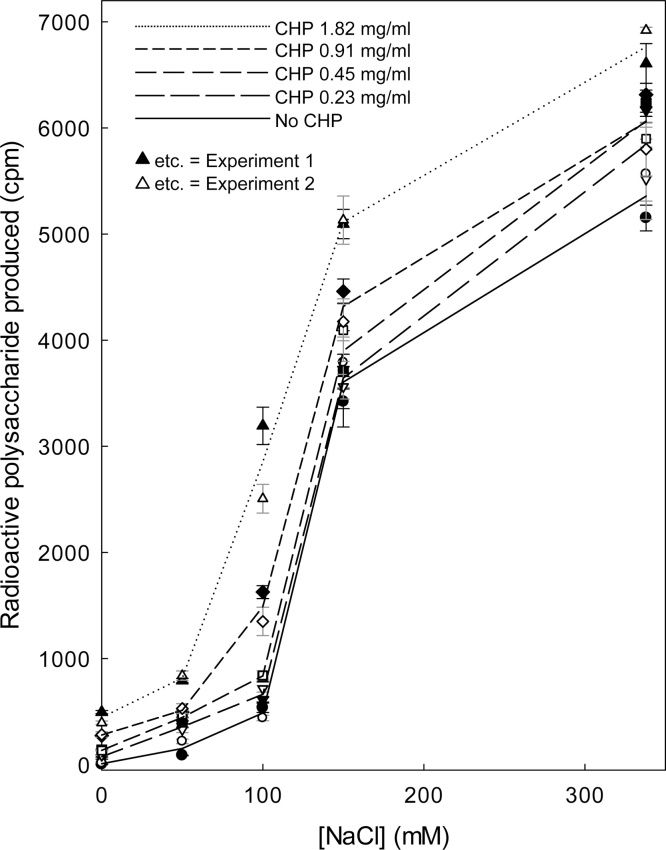
CHP and NaCl synergistically solubilise XET activity from Arabidopsis cell walls. Frozen/washed Arabidopsis cells were incubated for 1 h in 66 μl of buffer [183 mM MES (Na+), pH 5.5] containing various combinations of CHP and NaCl. After centrifugation, 20 μl of supernatant was incubated with XET reaction mixture and the yield of [3H]polysaccharide at 16 h was determined ±SE. The experiment was carried out five times with similar results; data from two runs (‘experiments 1 and 2′, represented by filled and open symbols respectively) are combined here. The lines interconnect the means of the two experiments. In these experiments, the volume sampled had contained 1.0 kBq [3H]XXXGol (carrier-free); the theoretical maximum yield of polysaccharide product was about 17,000 cpm.